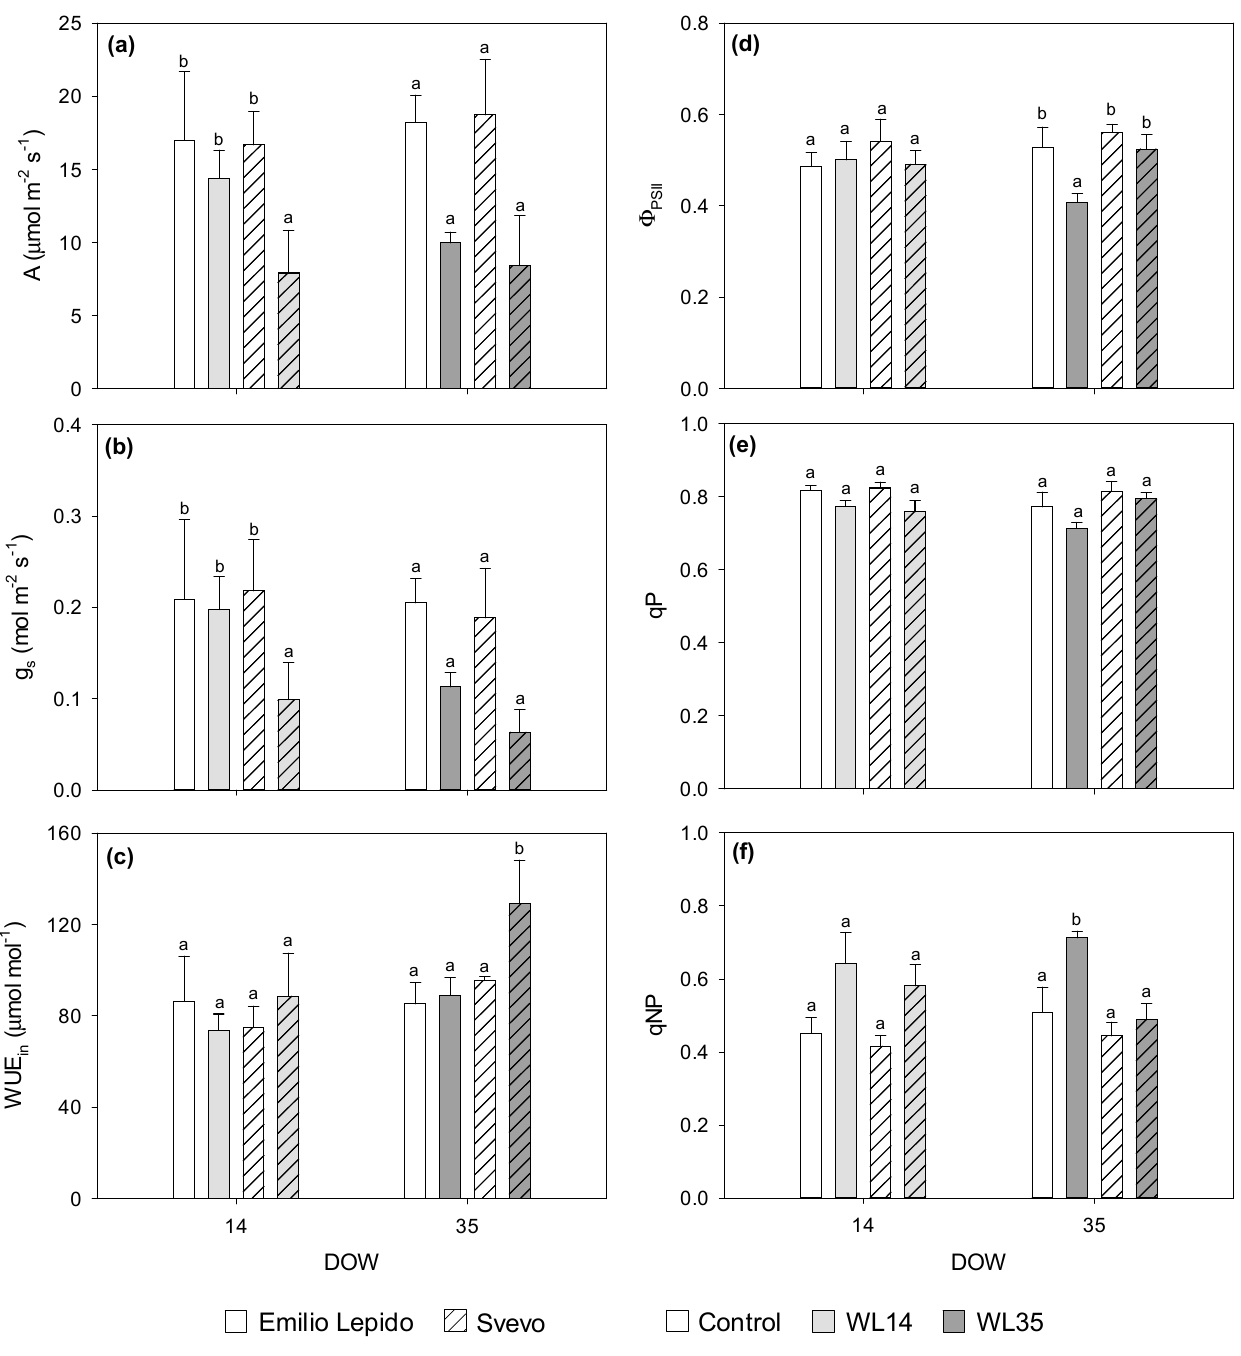
Figure 2. ( a ) CO 2 assimilation rate (A), ( b ) stomatal conductance (g s ), ( c ) intrinsic water-use efficiency (WUE in ), ( d ) PSII-operating efficiency in light conditions ( Φ PSII ), ( e ) photochemical quenching (qP), and ( f ) non-photochemical quenching (qNP) in the durum wheat cultivars Emilio Lepido (solid) and Svevo (pattern) subjected to 0 (i.e., control; white), 14 (i.e., WL14; light gray), or 35 (i.e., WL35; dark gray) days of waterlogging (DOW). Data are mean ± standard deviation. For each waterlogging duration, according to Tukey’s post hoc test ( p ≤ 0.05), different letters indicate significant differences among means ( p ≤ 0.05).